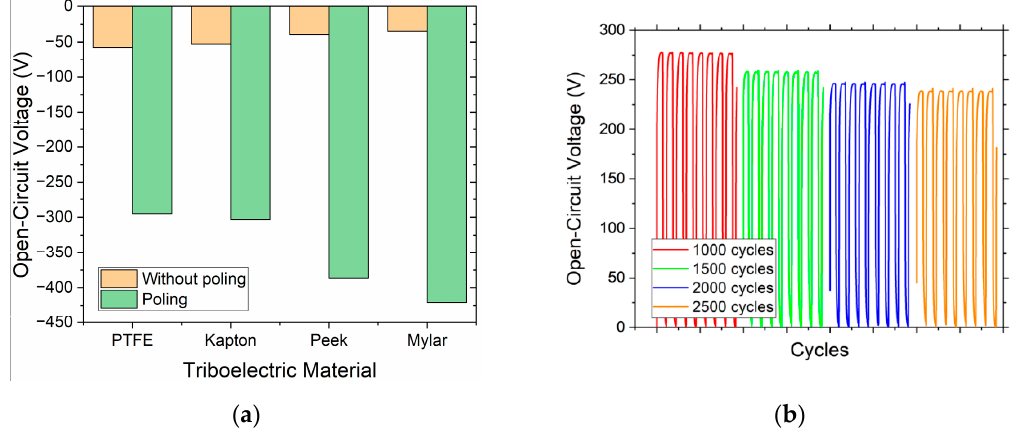
Figure 6. ( a ) Comparison of voltages generated with the different samples of polarized materials for 15 min and a voltage of 6000 V; ( b ) measurements of eight contact cycles for each material to validate the permanent effect of polarization.